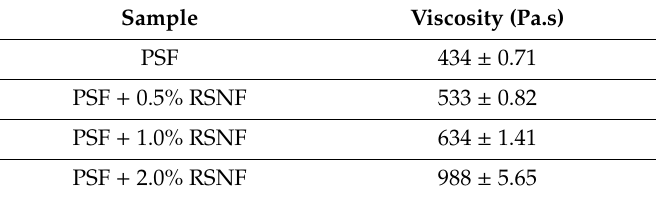
Table 1. Effect of rice straw nanofibers (RSNF) content on viscosity of polysulfone (PSF) solution. Table 1. E ff ect of rice straw nanofibers (RSNF) content on viscosity of polysulfone (PSF)